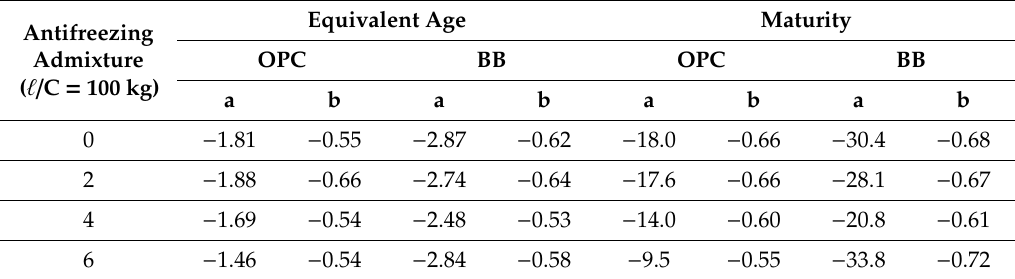
Table 5. Experimental coe ffi cients